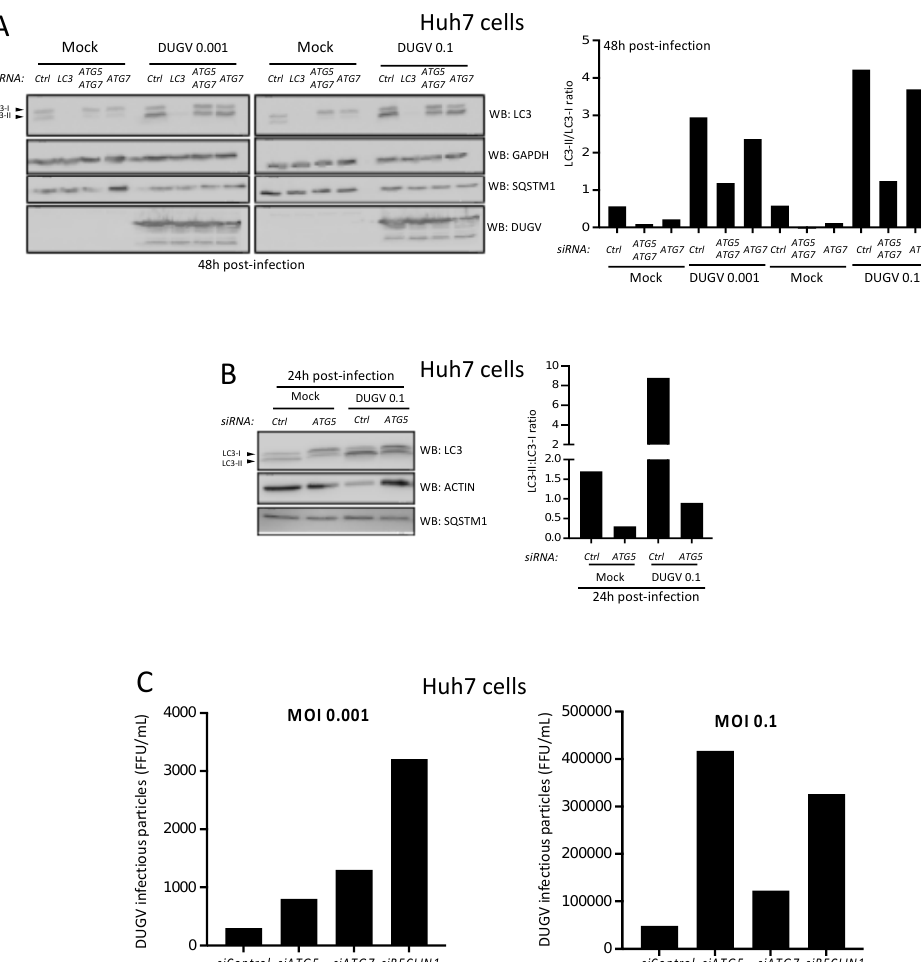
Figure 3. The influence of autophagy genes on DUGV infection-associated LC3 lipidation and virion production. ( A , B ) Huh7 cells were left uninfected (Mock) or infected with DUGV at MOI 0.1 and 0.001 for 48 h ( A ) or 0.1 for 24 h ( B ) in the presence of siRNA targeting either ATG7 , ATG5 plus ATG7 , MAP1LC3A-C (LC3), or ATG5 (along with control siCtrl) and analyzed by Western blot for the level of LC3 lipidation. Membranes were also examined for signals corresponding to GAPDH or ACTB, SQSTM1/p62 (SQSTM1), and DUGV proteins (DUGV). For each depicted blot, the associ- ated quantification represents the LC3-II:LC3-I ratio. ( C ) Huh7 cells were treated with siRNA tar- geting ATG5 , ATG7 , or BECLIN1 genes (versus siCtrl) for 48 h. Cells were then infected (MOI 0.1 and 0.001) with DUGV and the distinct conditions were analyzed for the amount of infectious viral particles produced after 48 h of infection. Values from titration in VeroE6 cells are expressed as focus-forming unit (FFU)/mL (one experiment for each MOI). 3.4. DUGV Particle Production by Epithelial Cells Is Sensitive to Autophagy Additional silencing experiments were conducted to delineate the role of autophagy on the outcome of Huh7 cell infection by DUGV. ATG5 , ATG7 , and BECLIN1 were tar- geted for 48 h prior to infection (MOI 0.001 and 0.1), and the influence of the silencing on the capacity of Huh7 cells to produce infectious DUGV particles was assessed by running a plaque assay on VeroE6 cells with dilutions of culture supernatants that were collected 48 h post-infection. We noticed a trend towards a slight increase in the number of infec- tious DUGV particles produced by Huh7 cells infected at MOI 0.1 when ATG5 , ATG7 , or